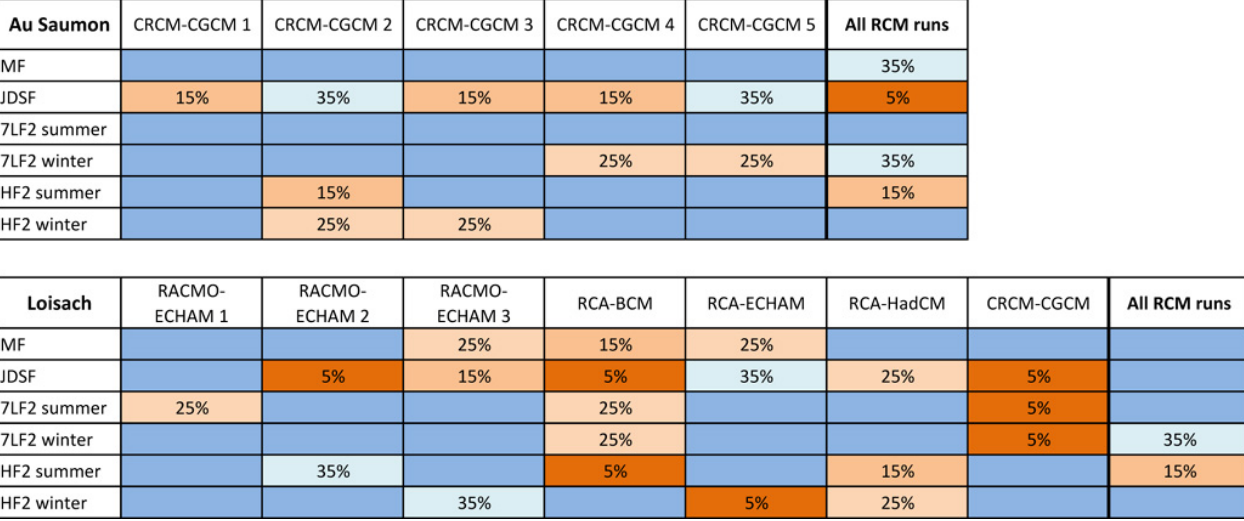
Fig. 9. Results of the Wilcoxon tests comparing BC0 with BC1 results for Saumon (au Saumon River) and Schlehdorf ( Loisach River). Boxes show either the level of rejection (5%, 15%, 25%, 35%) or no value if H0 was never